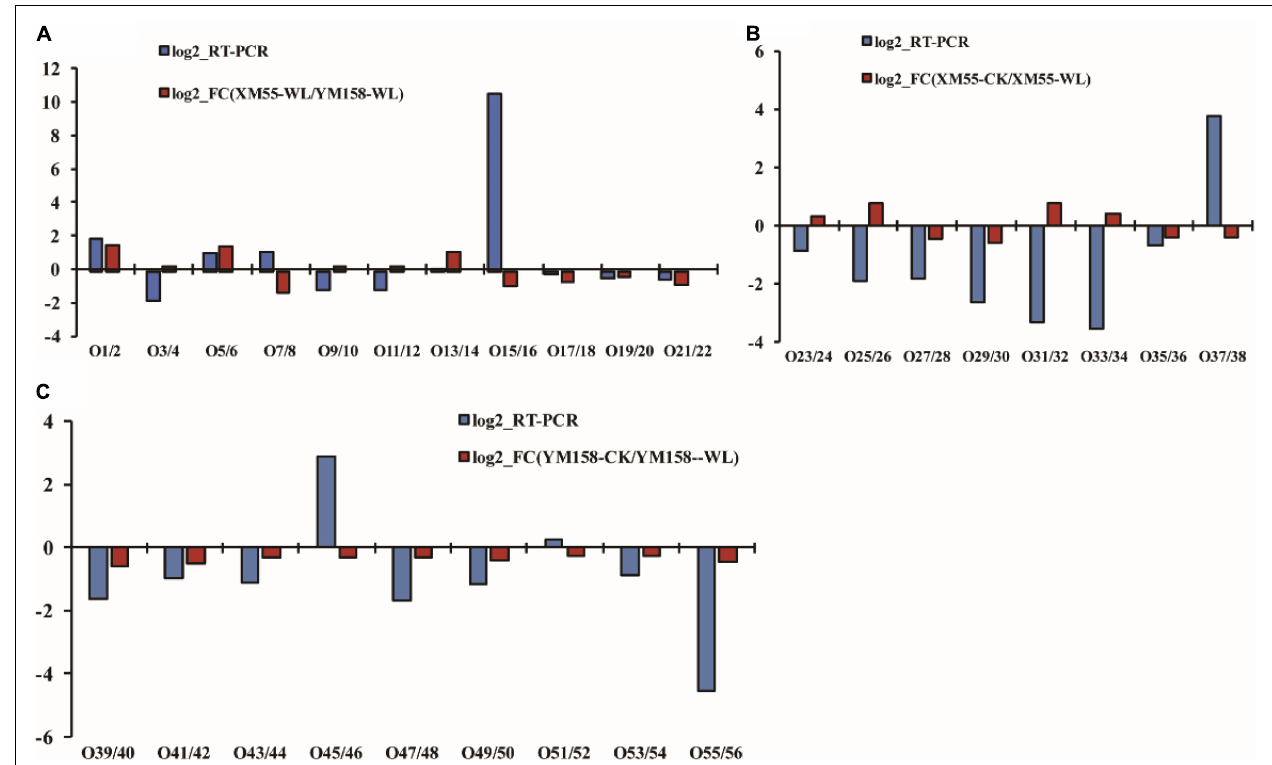
FIGURE 5 | Correlation of differentially expressed protein at transcript and translation level. Differences in protein expression and qRT-PCR between XM 55 and YM 158 under waterlogging stress. (A) Differences in protein expression measured by iTRAQ and quantitative real-time reverse transcription-PCR (qRT-PCR) in XM 55 (B) and YM 158 (C) under WL and CK. Log2-RT-PCR represents RNA expression level; Log2-FC represents the differences in protein expression